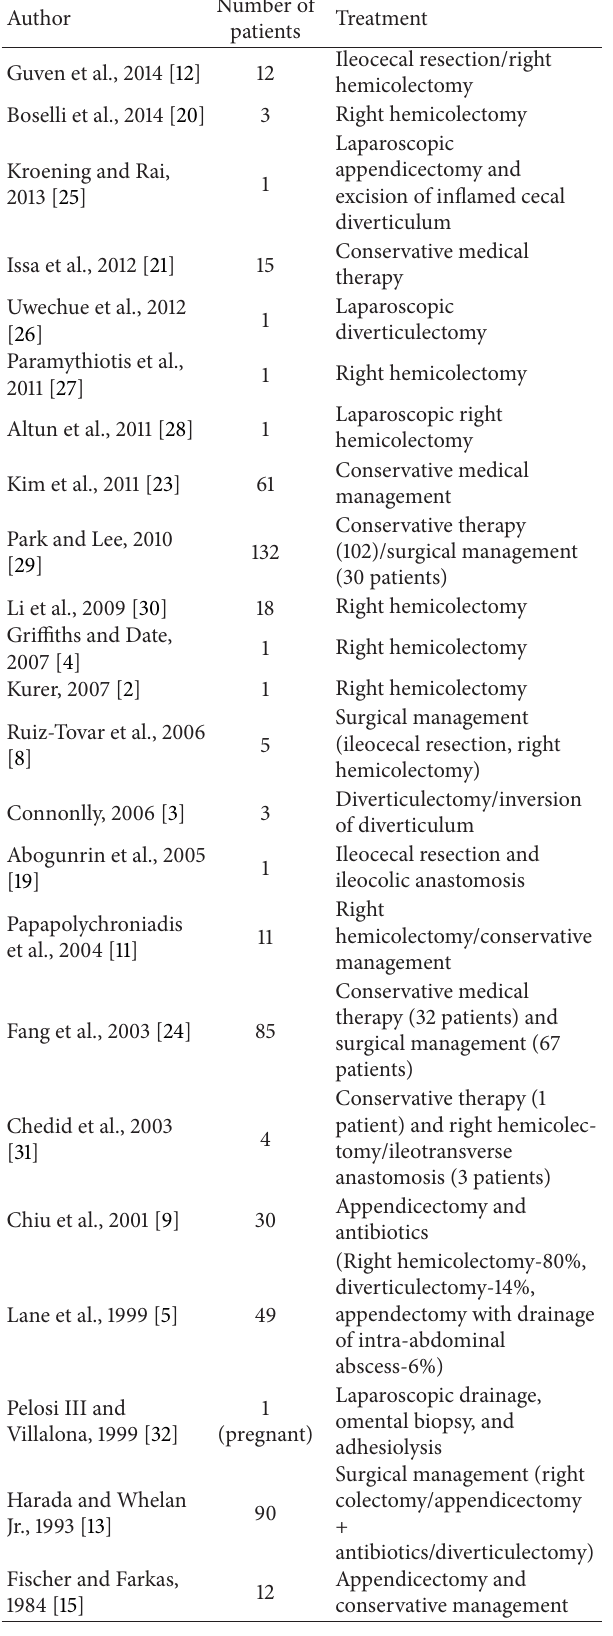
Table 1: Cases of cecal diverticulitis and therapeutic